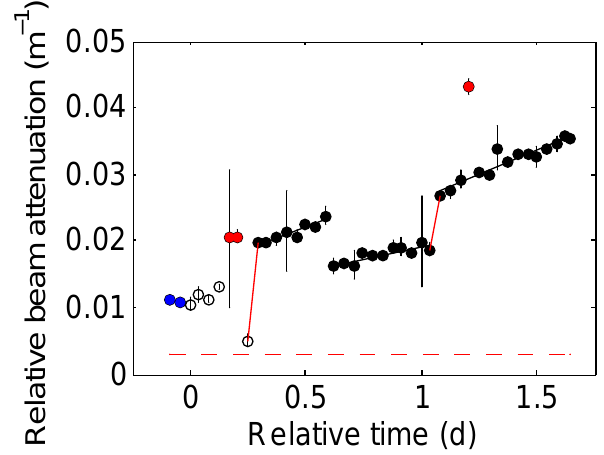
Fig. 3. Example of flux proxy determination, chosen because all pertinent features are represented. All points show drift-phase c p (650) observations, each the median of a 5-point “burst”. Vertical black lines show ± 70% interval within each burst (most are hid- den beneath symbols). Red circles show “spikes” not used in flux determination. The first two points (solid blue) were excluded to al- low for float to reach target depth; points marked with open circles did not satisfy goodness-of-fit criteria; see text. Filled black circles show points used for linear fitting of continuous flux component. Fitted segments (black lines) had relative slope uncertainties of 36, 45, and 21%. Positive jumps (solid red lines) were summed and normalized to the drift-phase length (dashed red line) to estimate the discontinuous flux